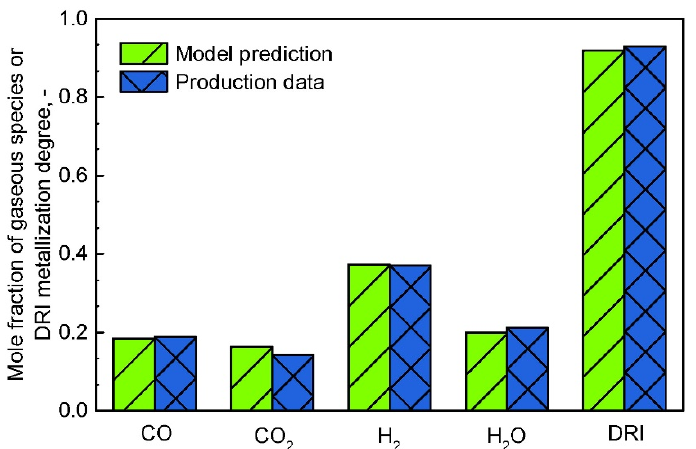
Figure 2. Comparisons between model prediction and industrial production data related to gaseous species in the top gas